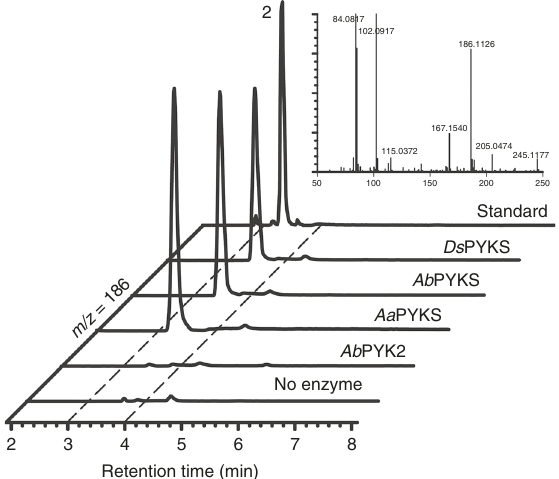
Fig. 2 LC-MS chromatograms at [M + H] + = 186 of product 2 in enzymatic reactions for Ds PYKS, Ab PYKS, Aa PYKS or Ab PKS2 using 1 and malonyl- CoA as